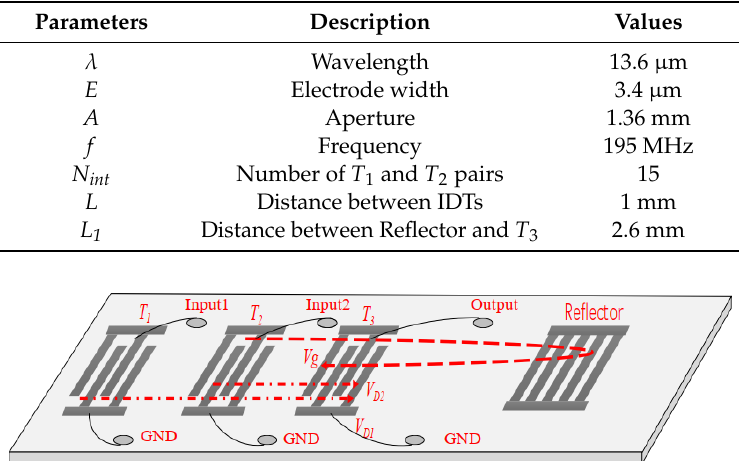
Table 1. Design parameters for the SAW device.